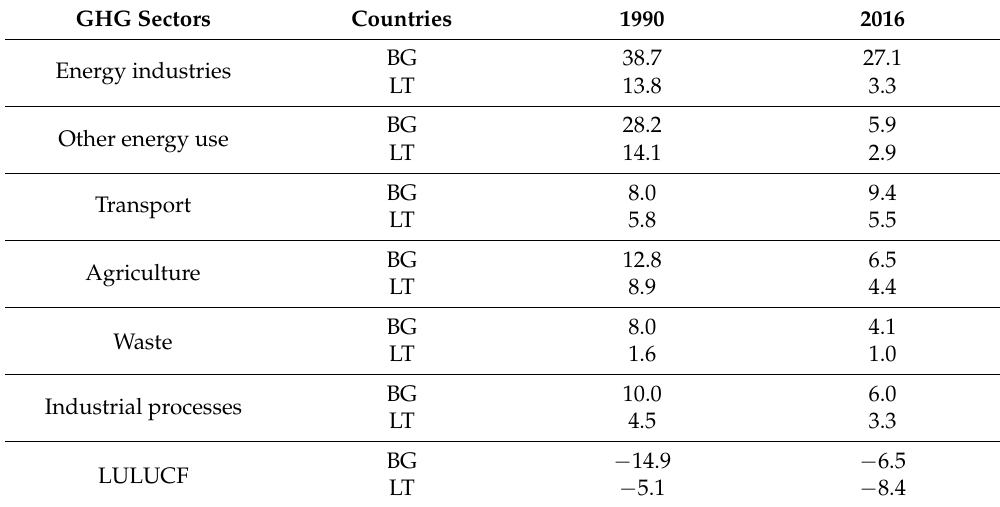
Table 1. GHG emissions and removals by sector between Lithuania and Bulgaria in 1990 and 2016, Mt CO2 eq. Source: [36,37]. LT: Lithuania; BG: Belgium. GHG Sectors Countries